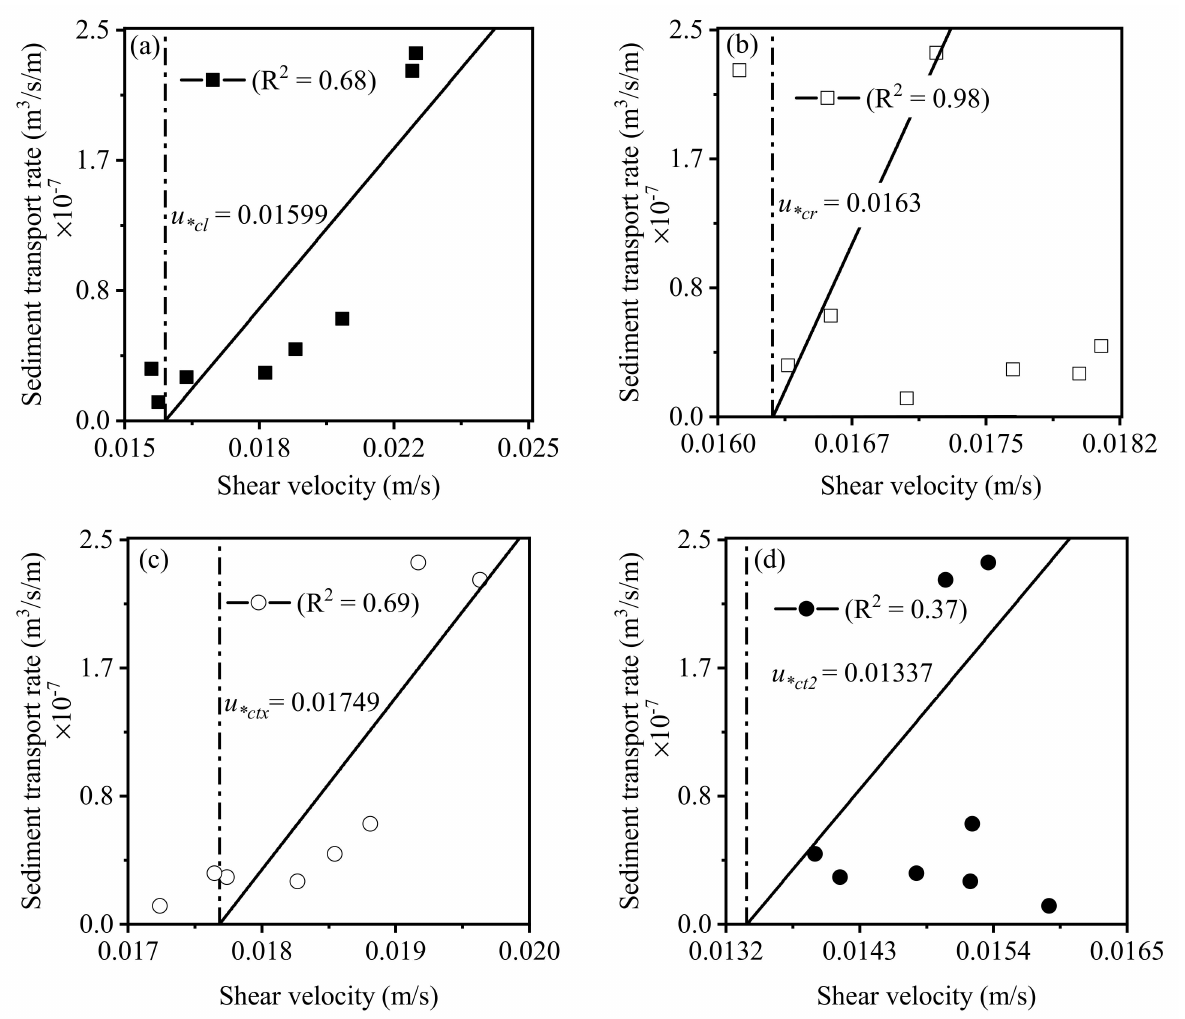
Figure 9. Estimation of critical shear velocity from shear velocity calculated by different indirect methods at sand zone: ( a ) regression analysis of universal logarithmic law; ( b ) Reynolds shear stress; ( c ) turbulence intensity considering x -component of flow; and ( d ) turbulence intensity considering y -component of flow.